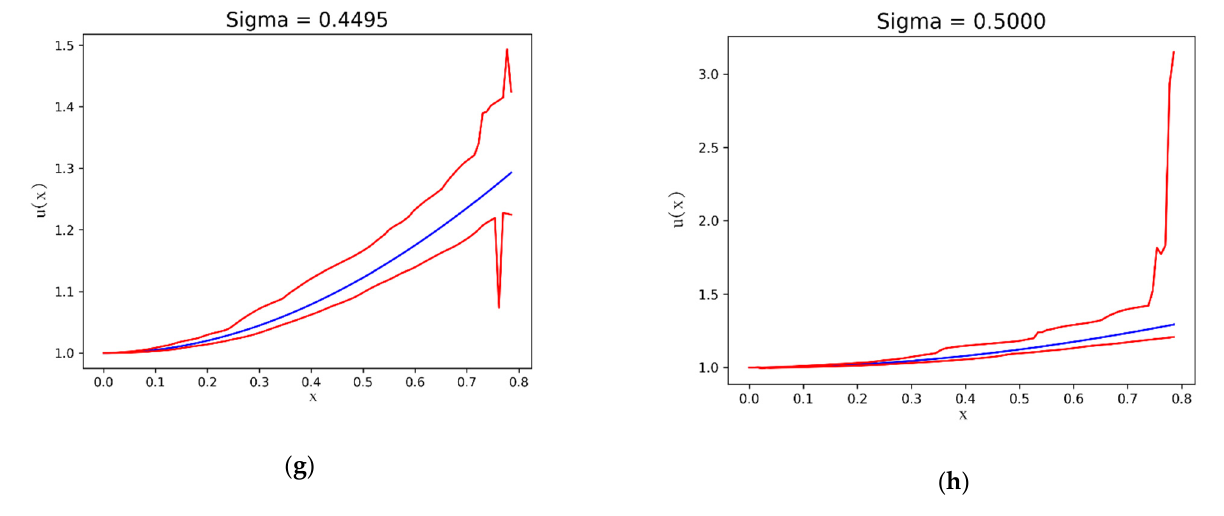
Figure 3. u ( x ) (blue line), U ( x ,100, σ ) (upper red line) and U ( x ,100, σ ) (lower red line) after 200 it- Figure 3. 𝑢(𝑥) (blue line), 𝑈(𝑥,100,𝜎) (upper red line) and 𝑈(𝑥, 100, 𝜎) (lower red line) after 200 erations for different values of the standard deviation: ( a ) σ = 0; ( b ) σ = 0.1010; ( c ) σ = 0.2525; iterations for different values of the standard deviation: ( a ) 𝜎 = 0 ; ( b ) 𝜎 = 0.1010 ; ( c ) 𝜎 = 0.2525 ; ( d ) 𝜎 = 0.2980 ; ( e ) 𝜎 = 0.3485 ; ( f ) 𝜎 = 0.3990 ; ( g ) 𝜎 = 0.4495 ; ( h ) 𝜎 = 0.500 . ( d ) σ = 0.2980; ( e ) σ = 0.3485; ( f ) σ = 0.3990; ( g ) σ = 0.4495; ( h ) σ = 0.500.